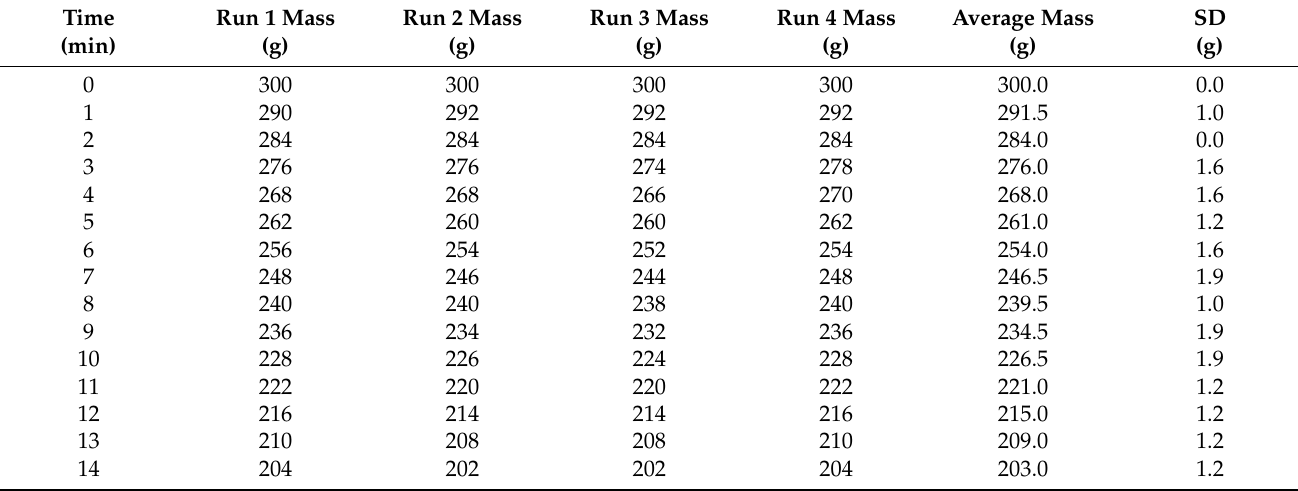
Table A2. Configuration B mass